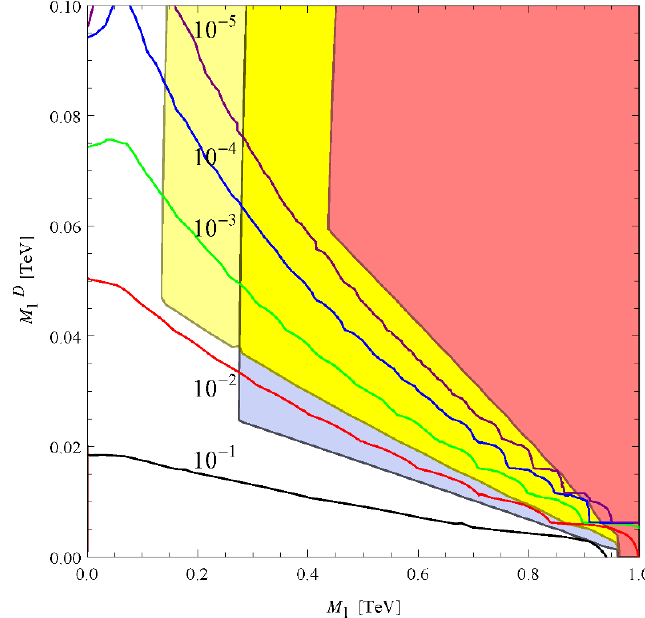
JHEP06(2017)122 decaying 2 having a decay temperature inferior to m B . 2 1 { 37